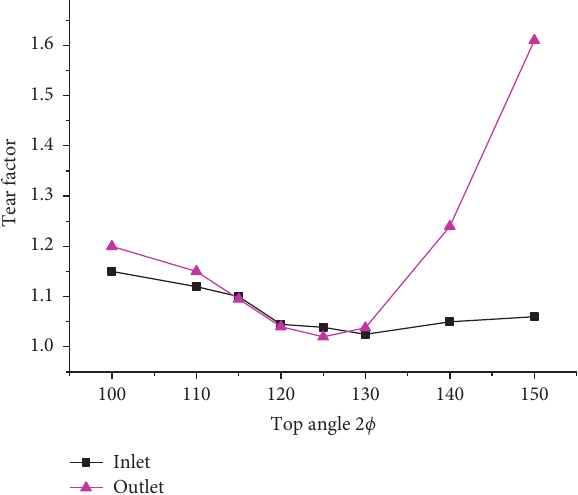
Figure 6: Delamination factor Fd at varying point